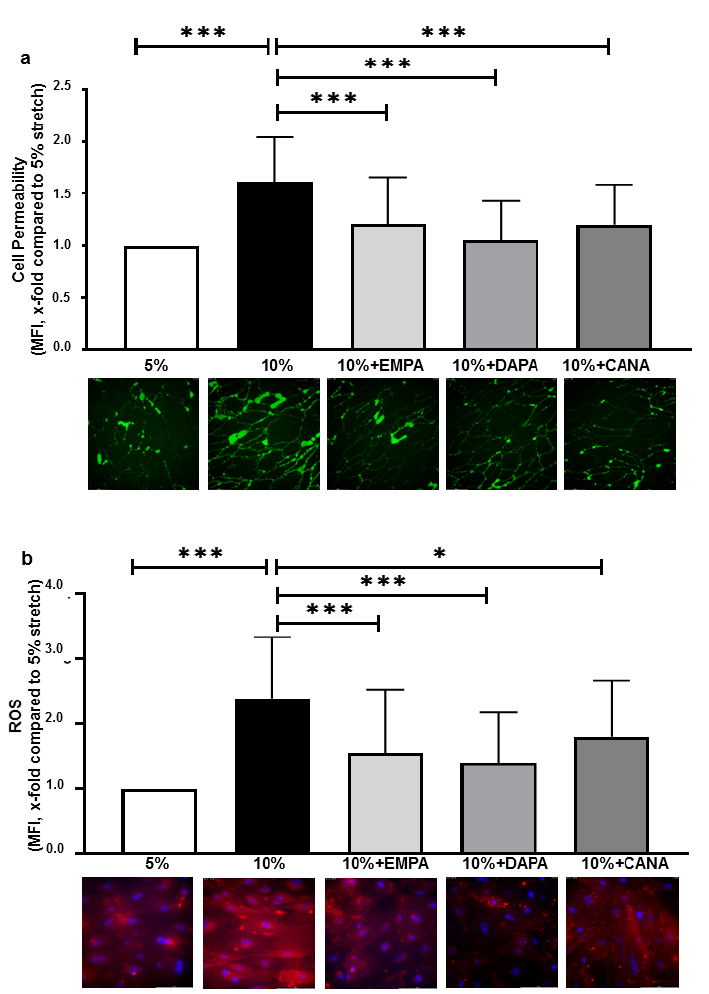
Figure 1. SGLT-2i’s inhibit barrier leakage and ROS production of HCAECs exposed to 10% stretch. Cells were pre-incubated for 2 h with vehicle or one of the SGLT-2i’s (1 µ M EMPA, 1 µ M DAPA and 3 µ M CANA), and were subsequently exposed to 5% stretch plus vehicle, 10% stretch with vehicle or SGLT-2i’s for 24 h. Cell permeability was measured with live cell imaging, and 6 images were made from each condition in each individual experiment ( a ) n = 5 individual experiments). ROS levels were measured at 24 h, and six images were taken from each condition in each individual experiment ( b ) n = 5 individual experiments). Representative images are shown in the lower panel and data are presented as mean ± SD. * p < 0.05 vs. 10% stretch, *** p < 0.001 vs. 10% stretch.